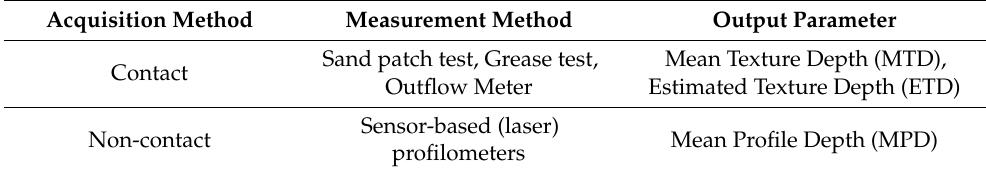
Table 1. Standard pavement macro-texture measuring methods and output